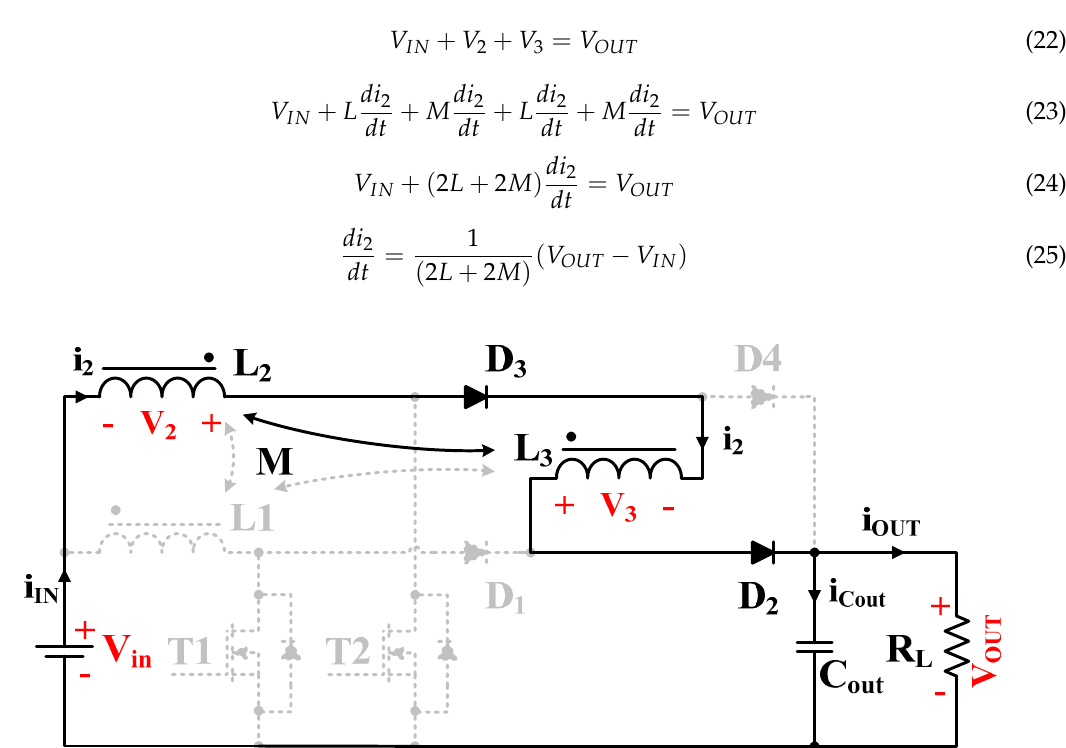
Figure 9. Equivalent circuit of proposed converter operation during 4th interval.